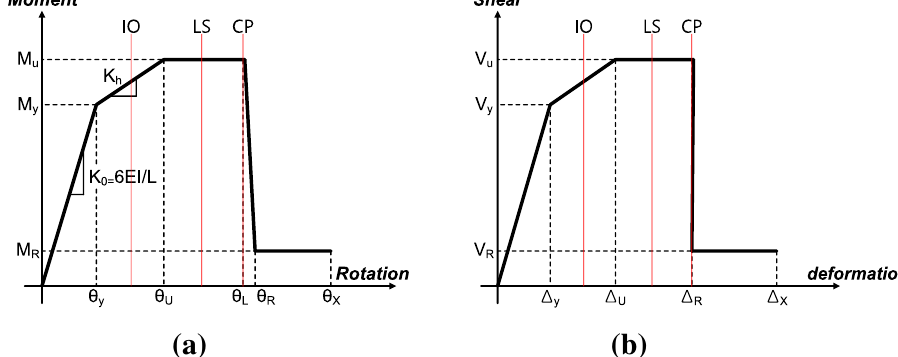
Fig. 9 Nonlinear model for connecting beams. a Moment–rotation relationship and b shear force–deformation relationship.